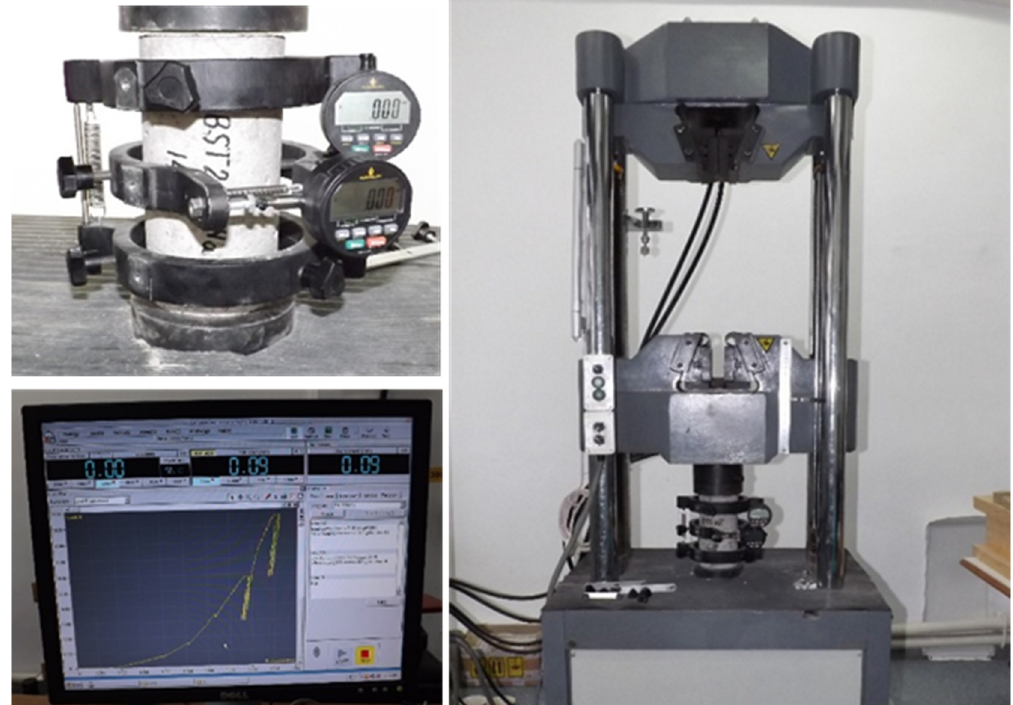
Figure 6. Equipment used to measure displacement in determining the modulus of elasticity of concrete.